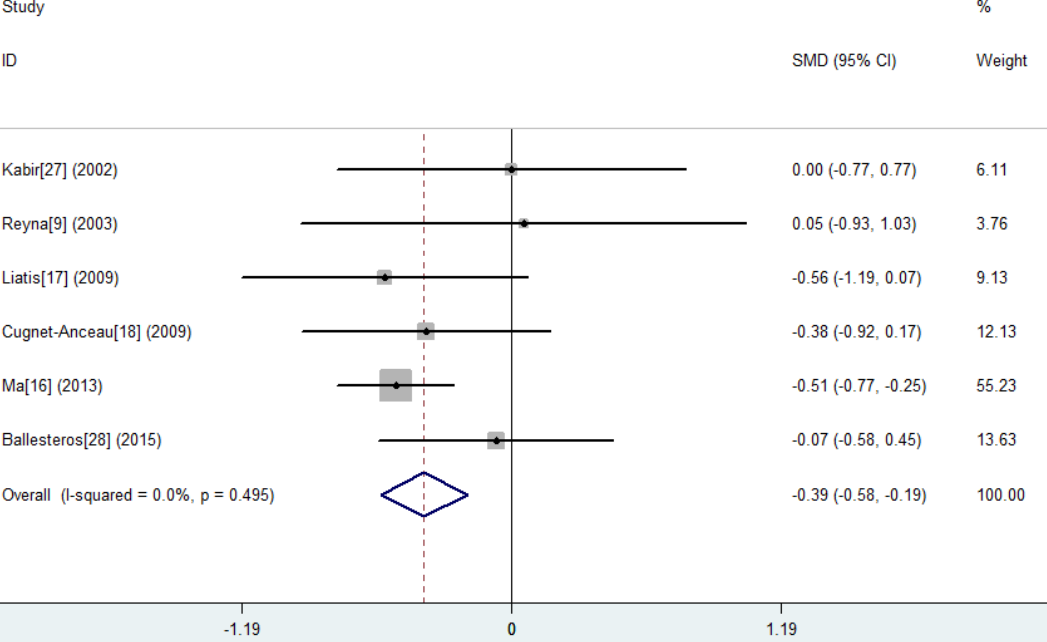
Figure 3. Results of the meta ‐ analysis carried out to investigate the effect of oat intake on fasting blood glucose (FBG). The changes from baseline (Mean ± SD) between the two groups were compared. MD, mean difference; CI, confidence interval.